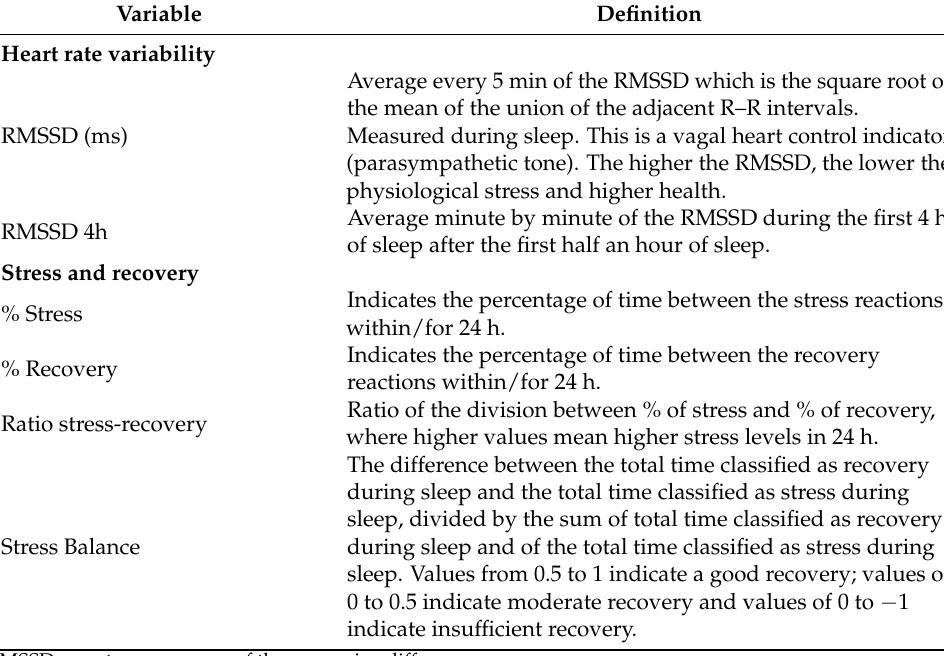
Table 1. Description of the